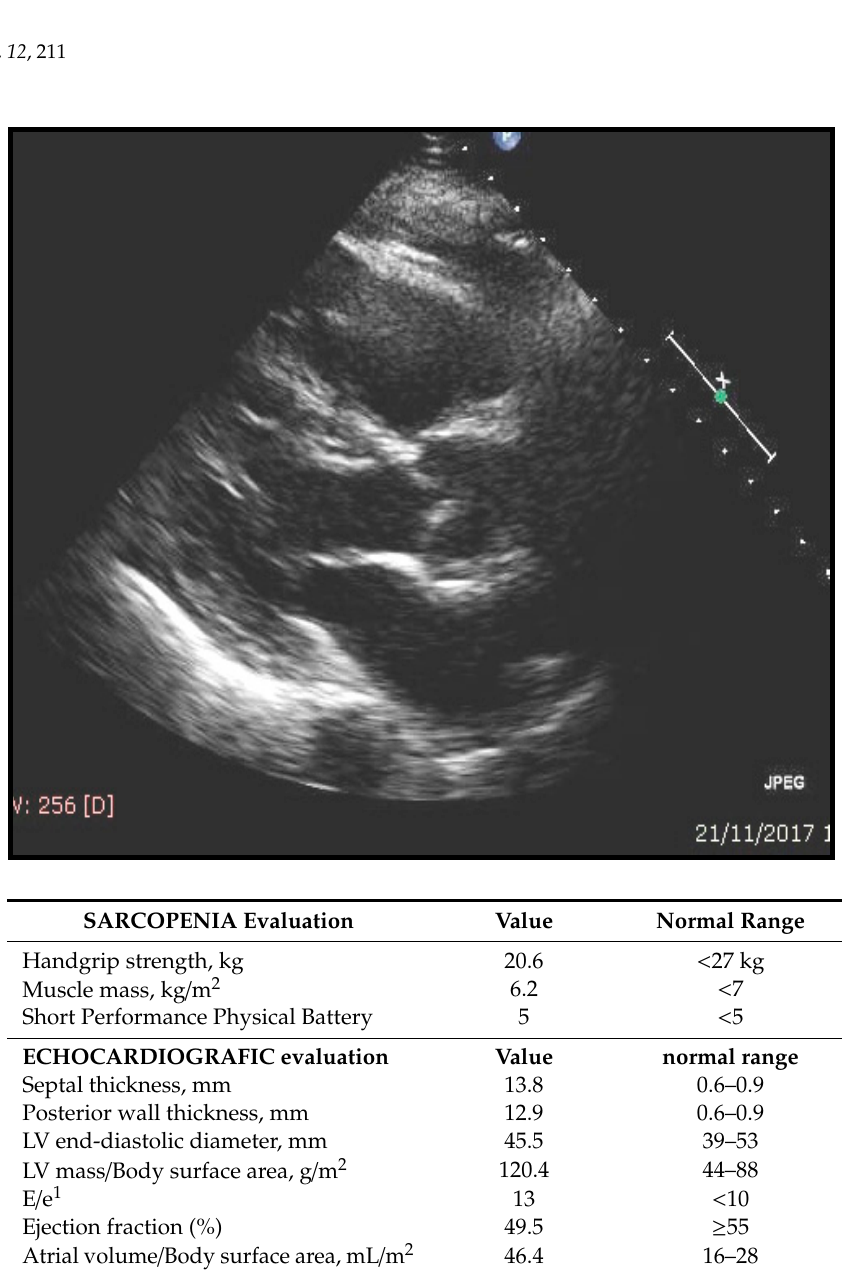
Figure 3. A typical example of sarcopenia and echocardiographic evaluation in an 82-year-old male patient. A reduction of strength and mass muscle is associated to “non-functional” cardiac hypertrophy (LV = left ventricular; E / e 1 = echocardiographic transmitral early peak velocity ( E ) by pulsed wave Doppler over e 1 ( E / e 1 ) represent a noninvasive surrogate for LV diastolic pressures for grading a diastolic dysfunction).